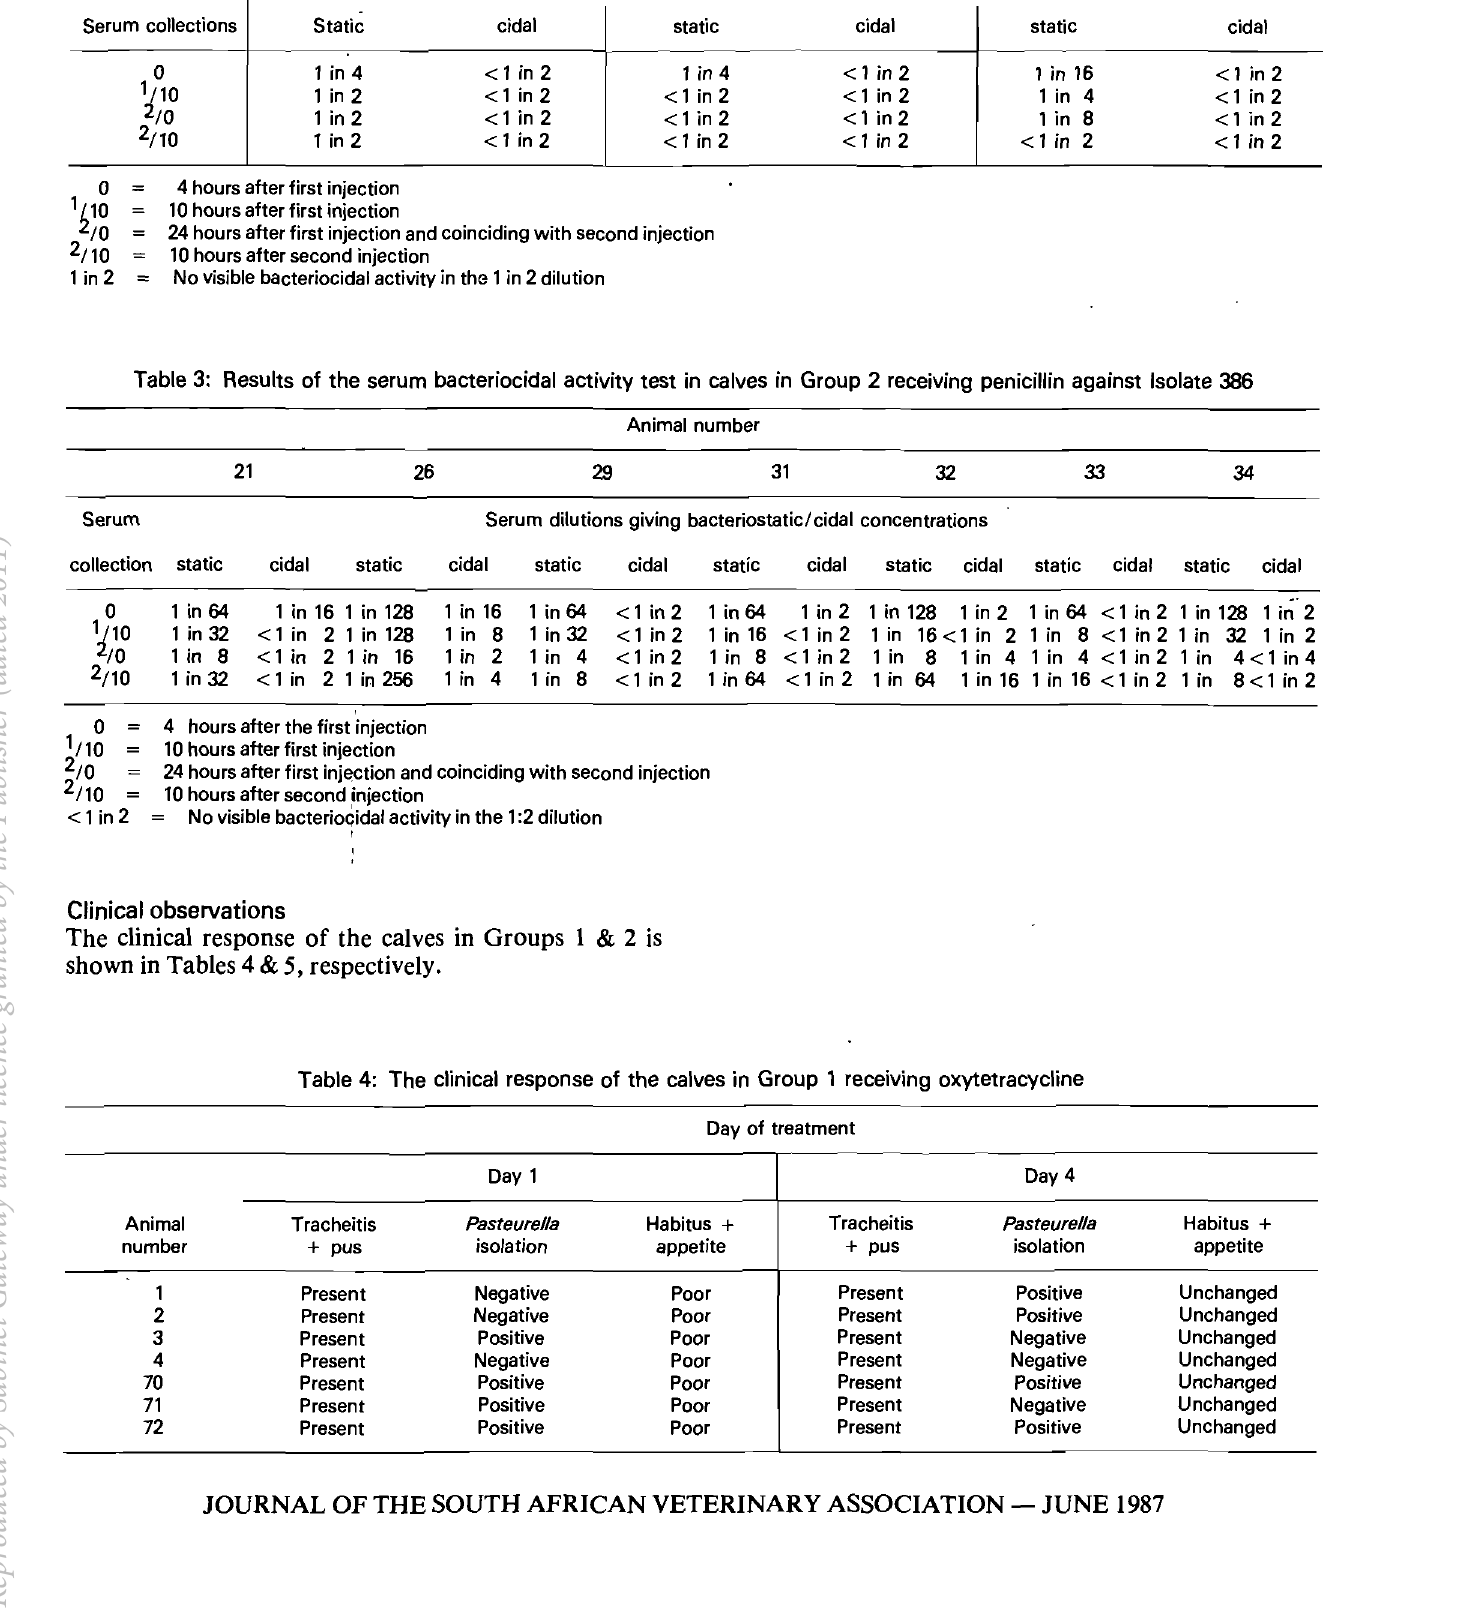
Table 2: Results of the serum bacteriocidal activity test in three calves in Group 1 receiving oxytetracycline against isolate 386 Animal number 1 4 723 Serum dilution giving bacteriostatic/ cidal concentrations